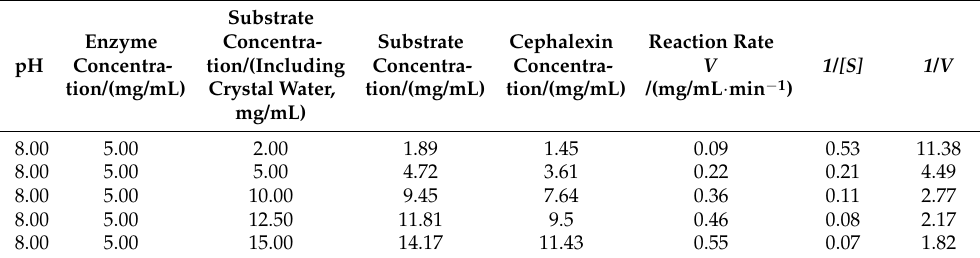
Table 14. The reaction rates with different substrate concentrations at pH of 8.00 and enzyme concentration of 5.00